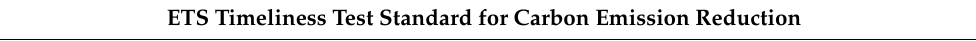
Table 4. Timeliness judgment criteria for ETS.